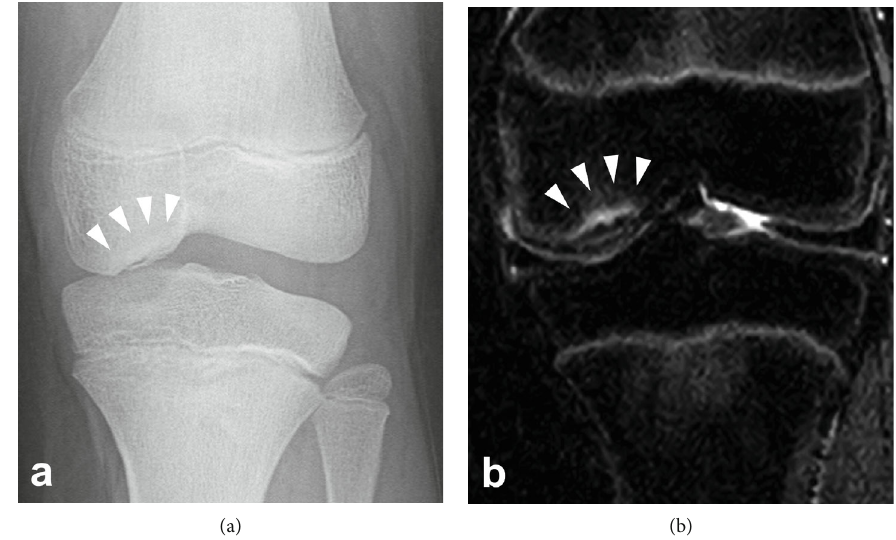
Figure 2: (a) Radiograph of the left knee showing Brückl ’ s stage IV OCD lesion in the MFC. (b) STIR MRI coronal image of the left knee indicating Nelson ’ s stage III lesion in the